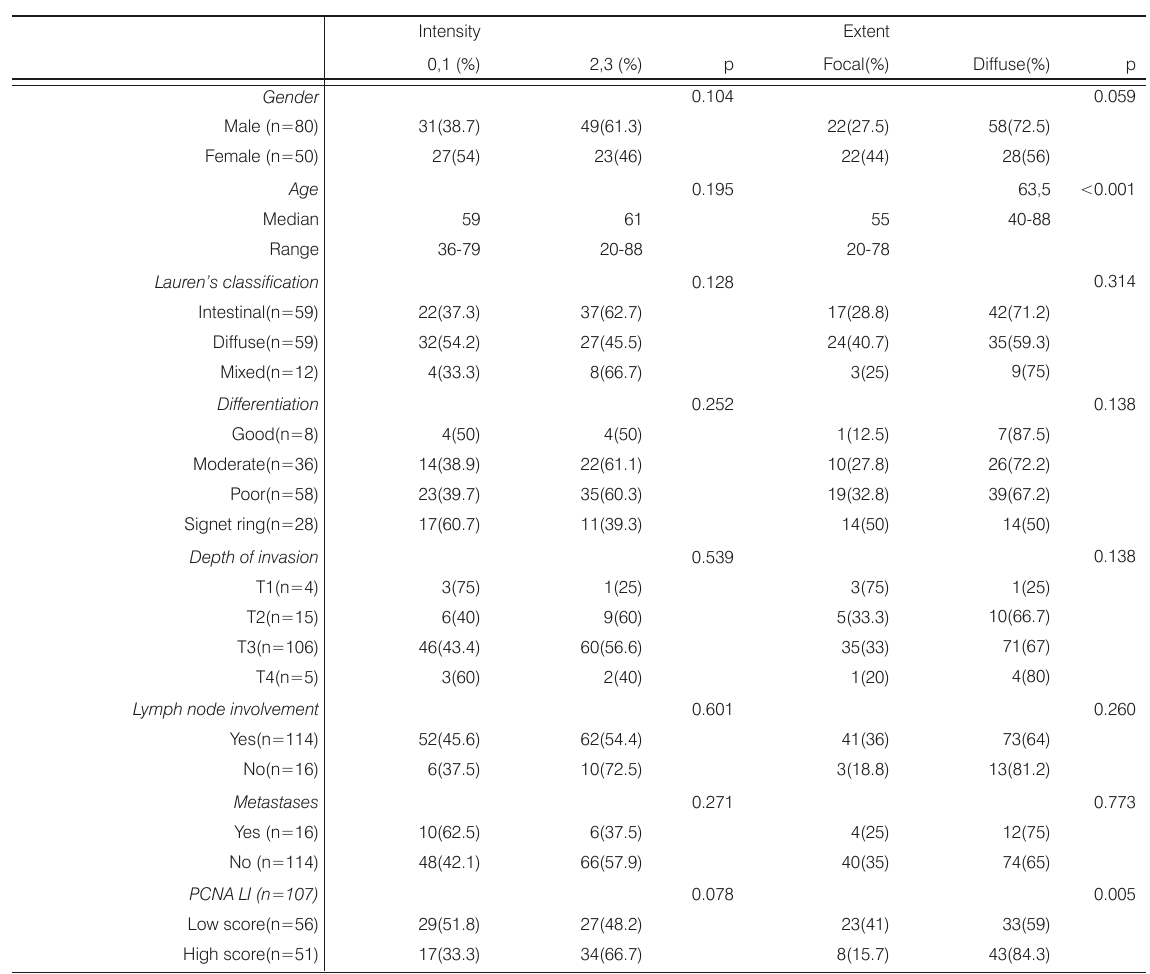
Table 2. Correlation of TS expression with baseline